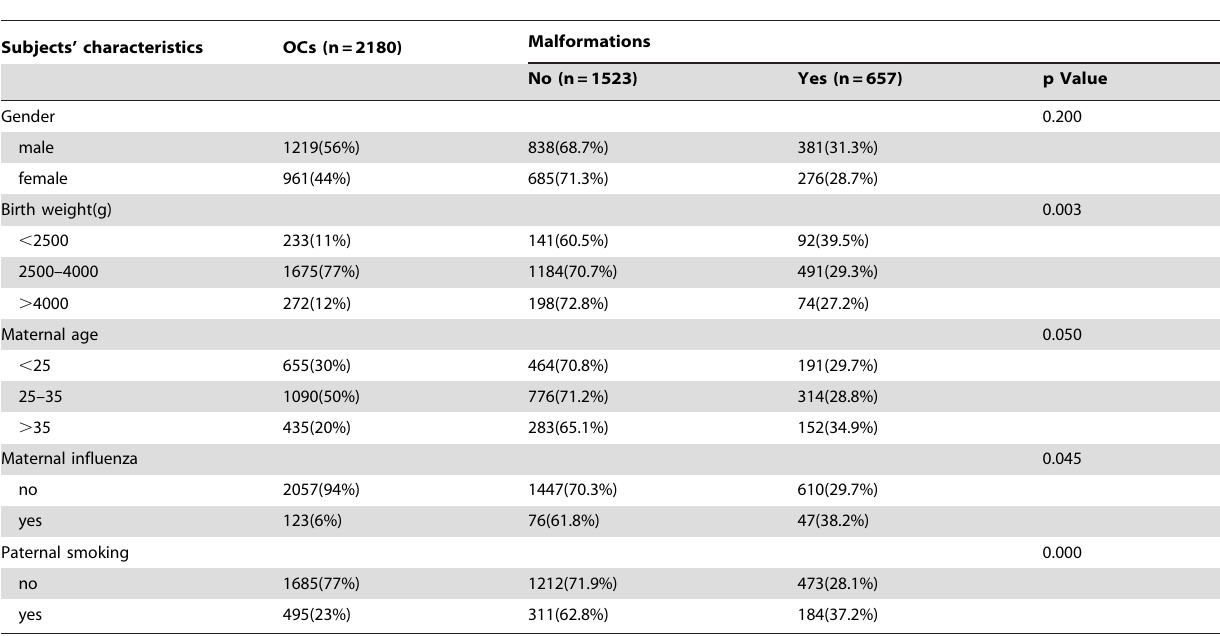
Table 1. Descriptive characteristics of children with orofacial clefts in Eastern China,